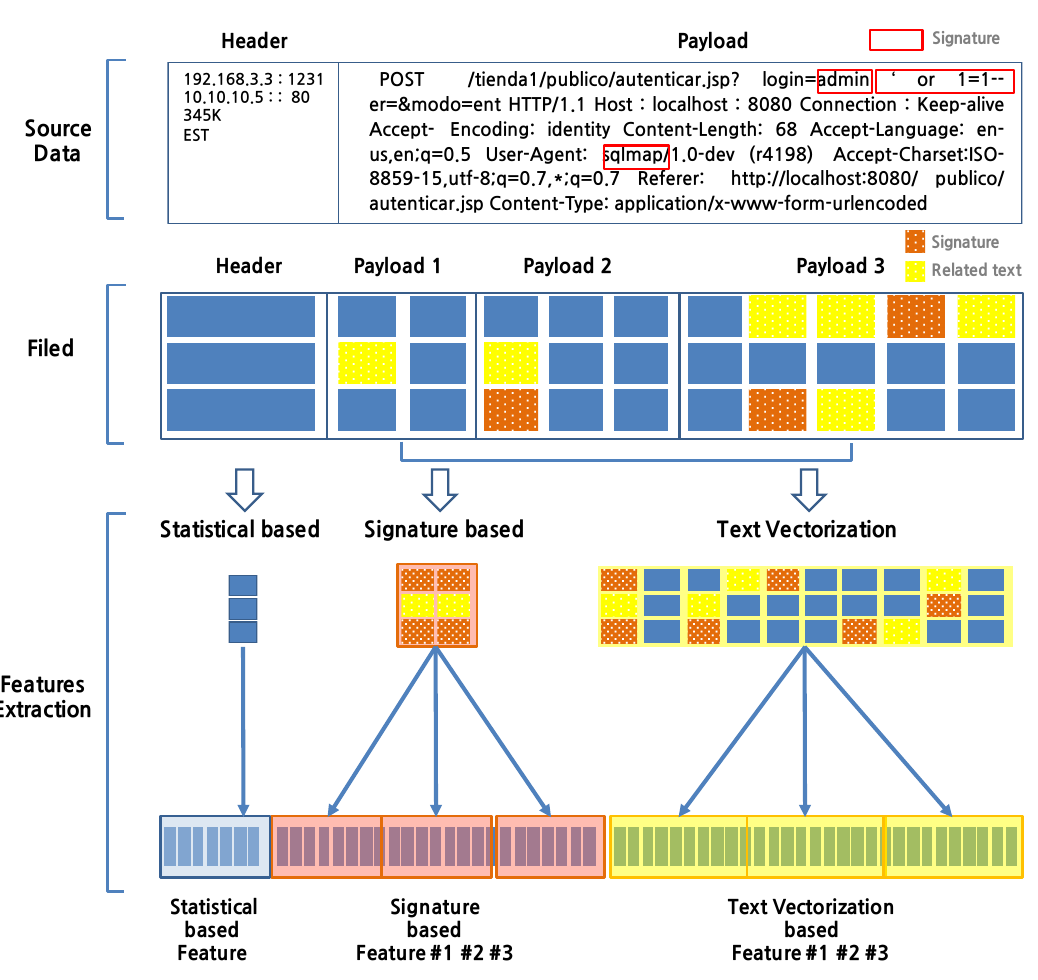
Figure 3. Payload based Feature